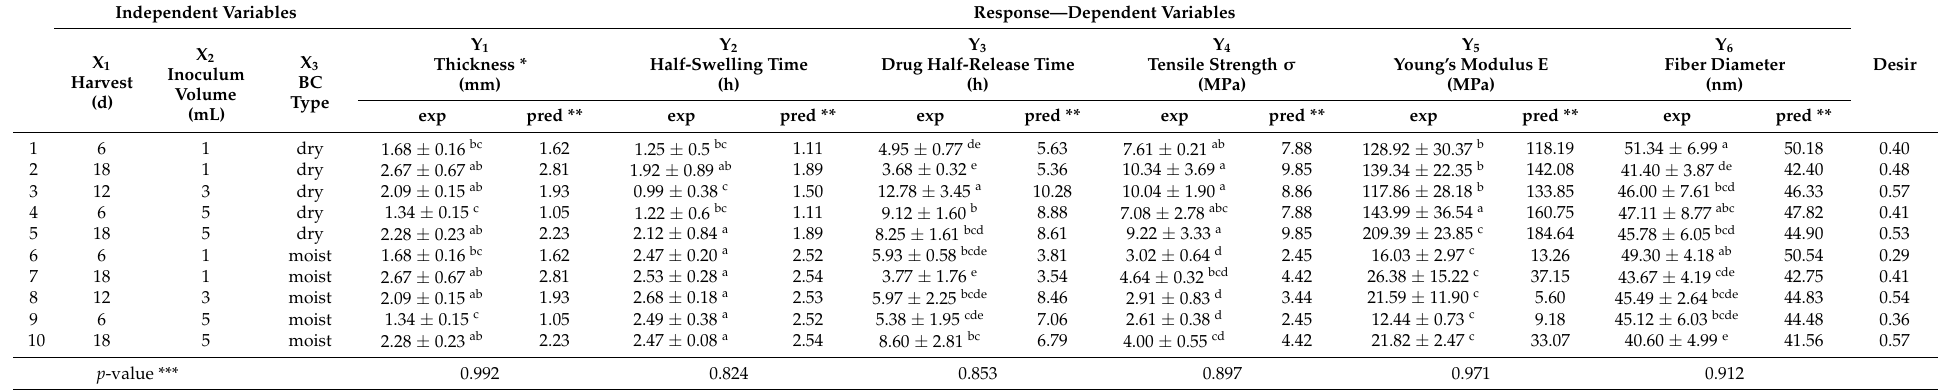
Table 2. The properties of bacterial cellulose (BC) of interest for biomedical purposes at different fermentation conditions based on a Box–Behnken design for response surface methodology